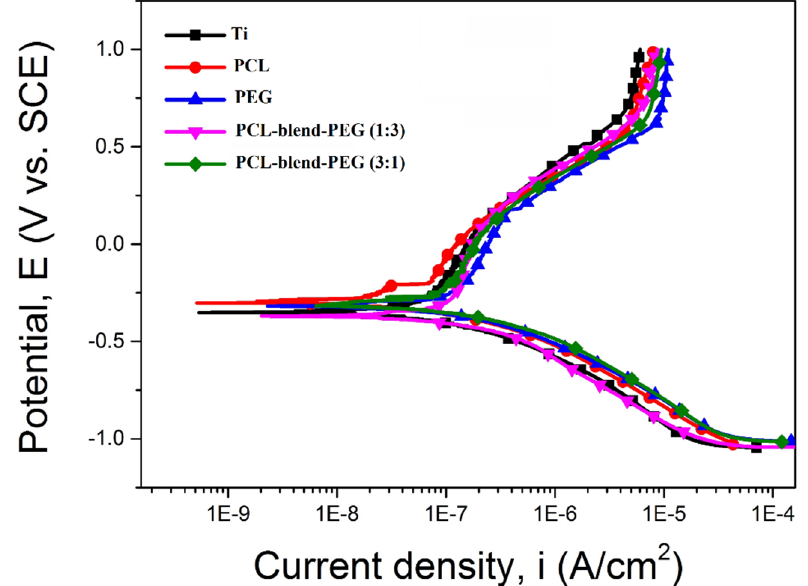
Figure 9. Potentiodynamic polarization curves of coatings and bare Ti substrate, respectively.